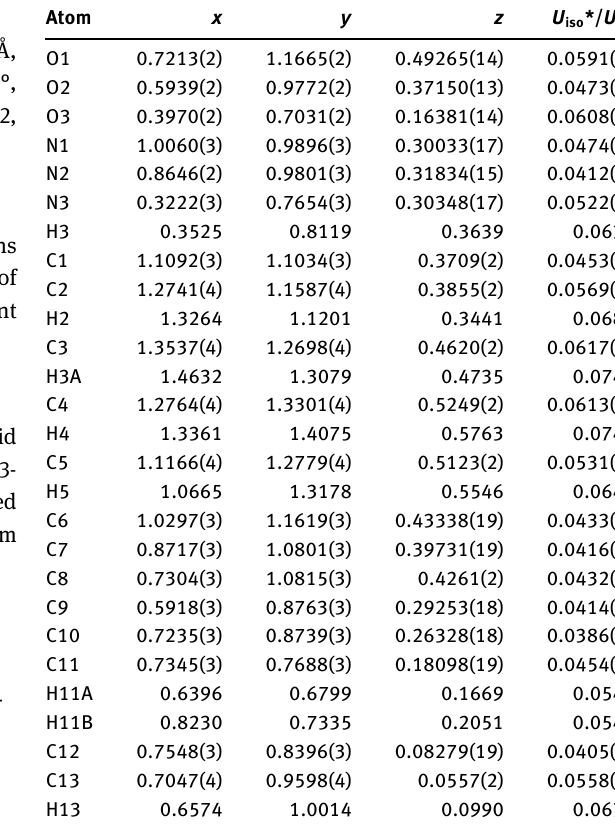
Table 2: Fractional atomic coordinates and isotropic or equivalent isotropic displacement parameters (Å 2